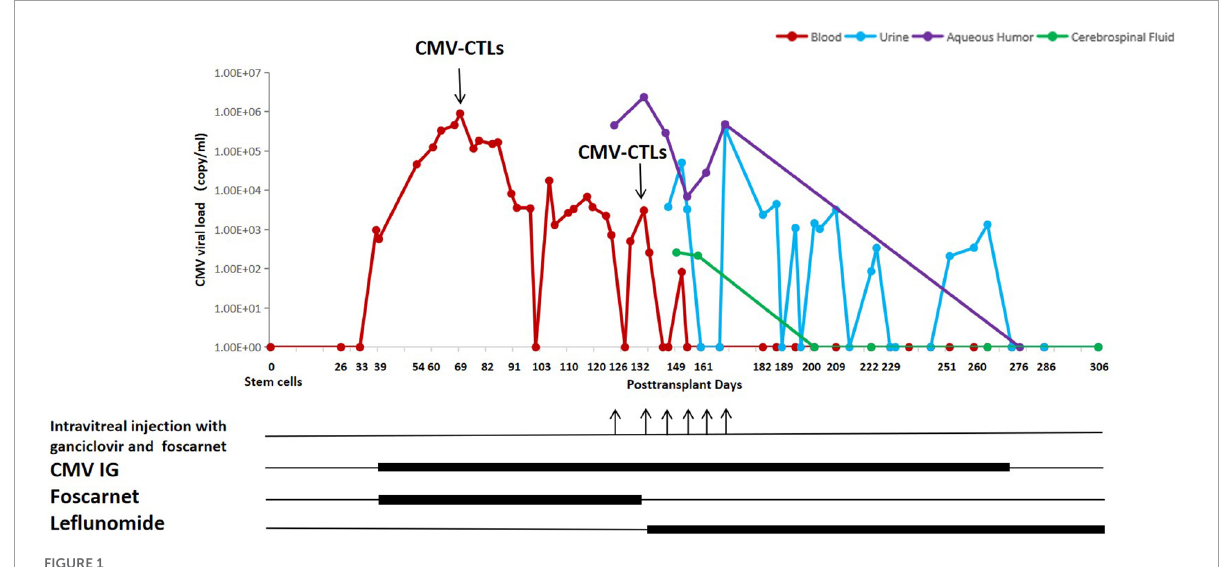
FIGURE1 CMV viral load and antiviral treatments of the patient.